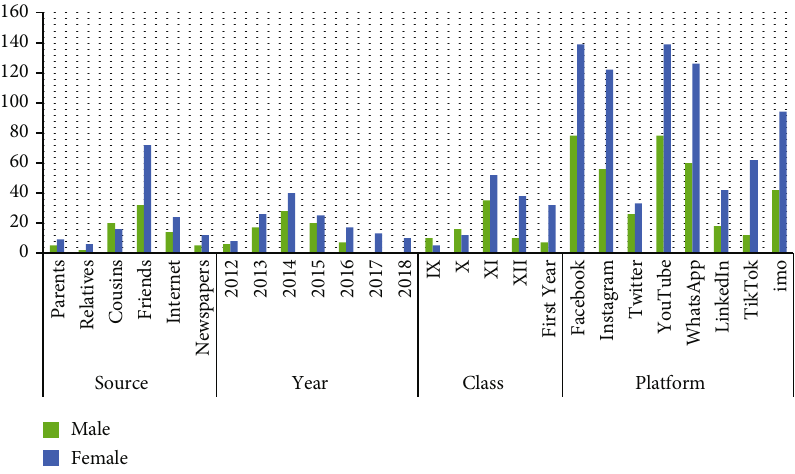
Figure 2: Social media